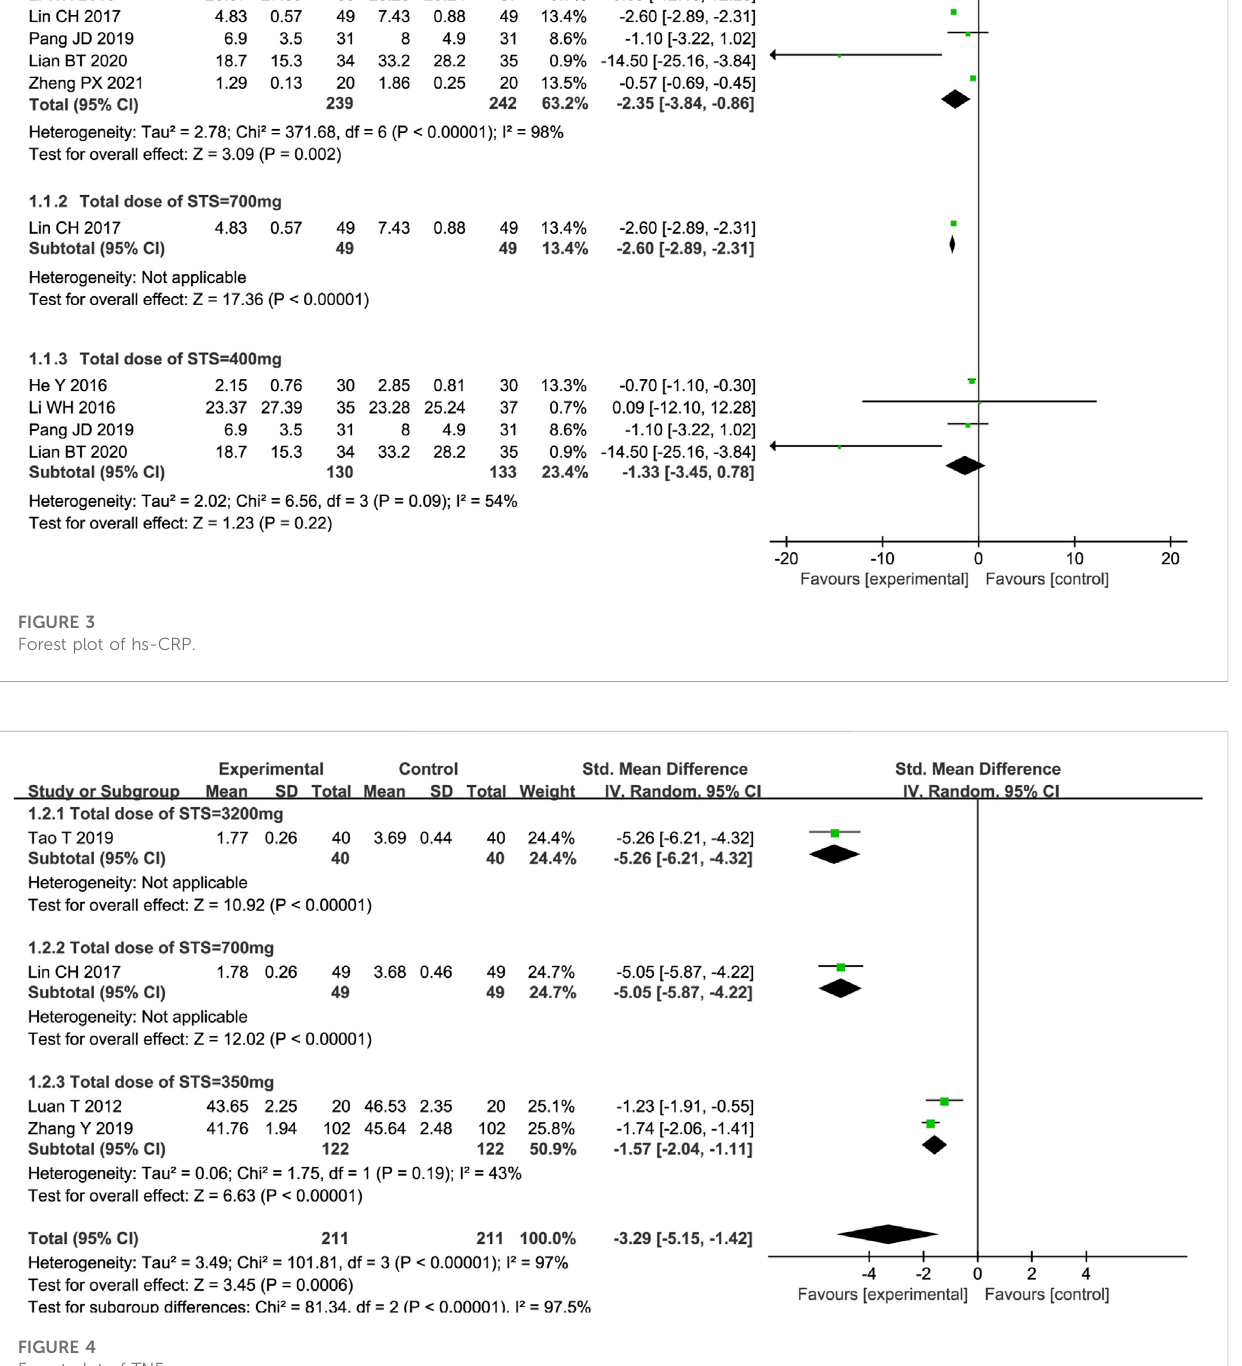
FIGURE 4 Forest plot of TNF- α